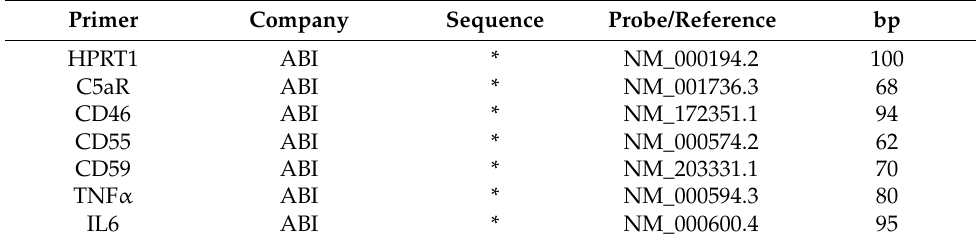
Table 1. Oligonucleotides used for qPCR